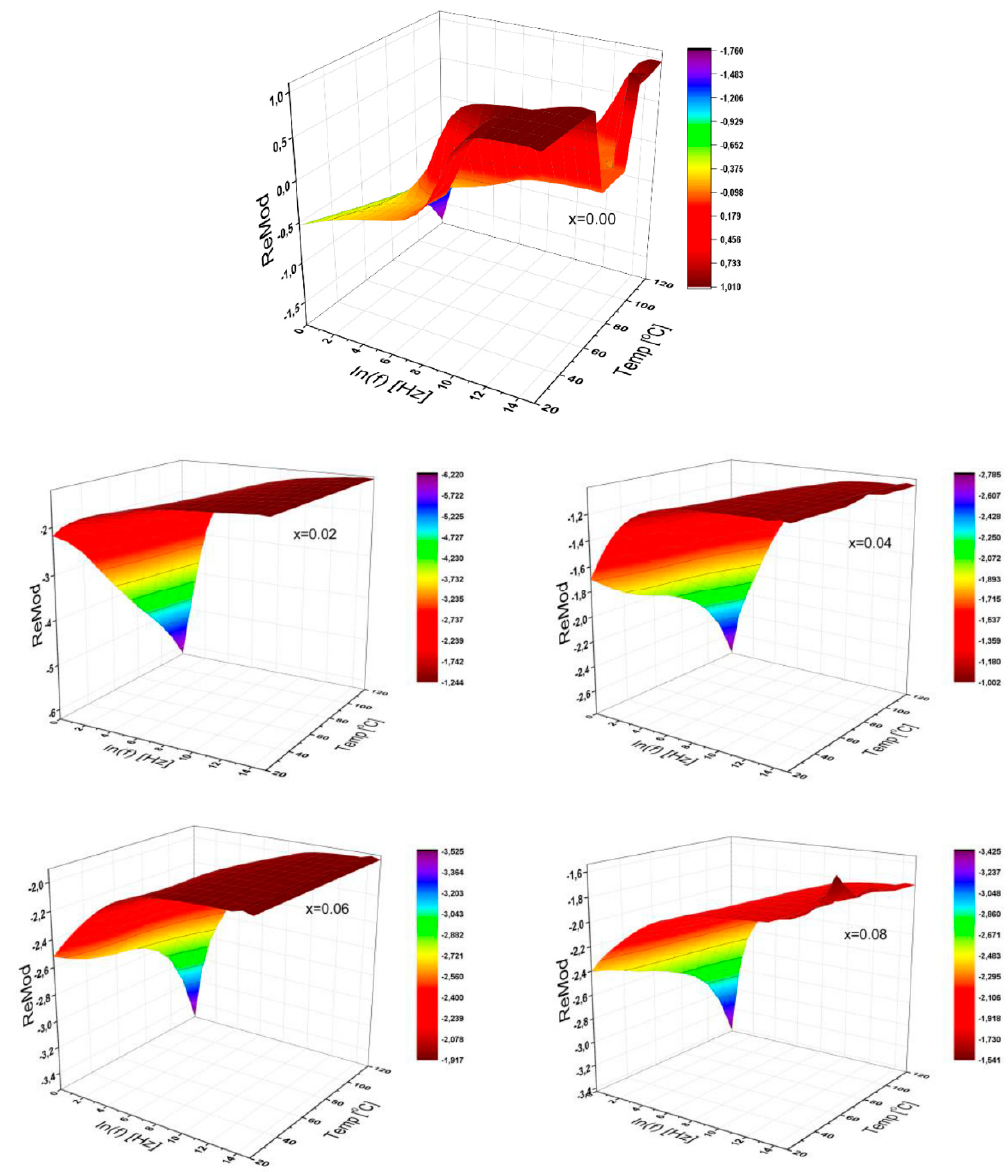
Figure 7. 3D characteristic plots of real modulus of SrNb x Fe 12 − x O 19 (0.00 ≤ x ≤ 0.08) HFs for a variety of substitutional Nb ions ratio as functions of frequency up to 3 MHz, and for temperatures up to 120 °C.